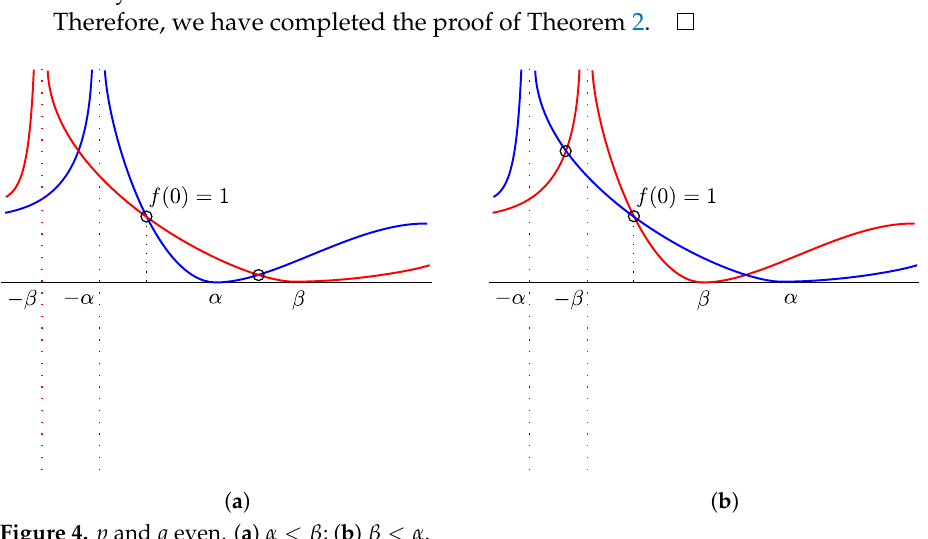
Figure 4. p and q even. ( a ) α < β ; ( b ) β < α